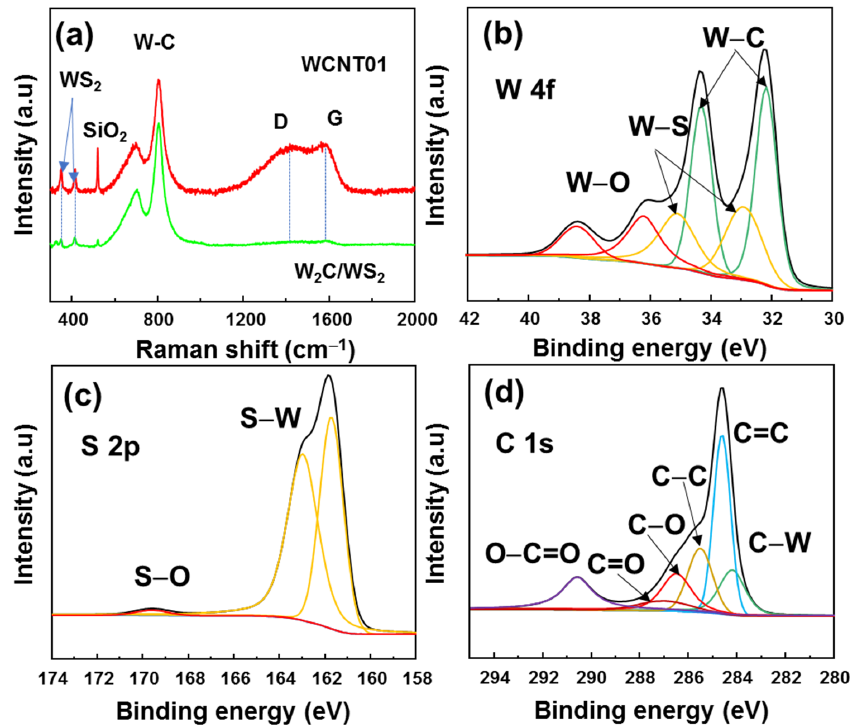
Figure 3. ( a ) Raman spectra of bare W 2 C / WS 2 and WCNT01 samples. High-resolution XPS spectra of ( b ) W 4f, ( c ) S 2p, and ( d ) C 1s of WCNT01 sample.